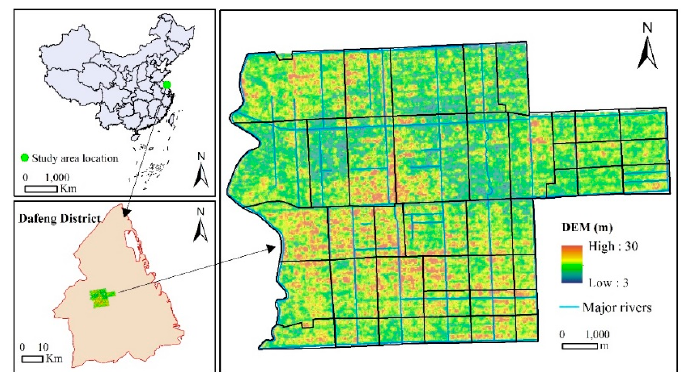
Figure 1. Location of the study area.